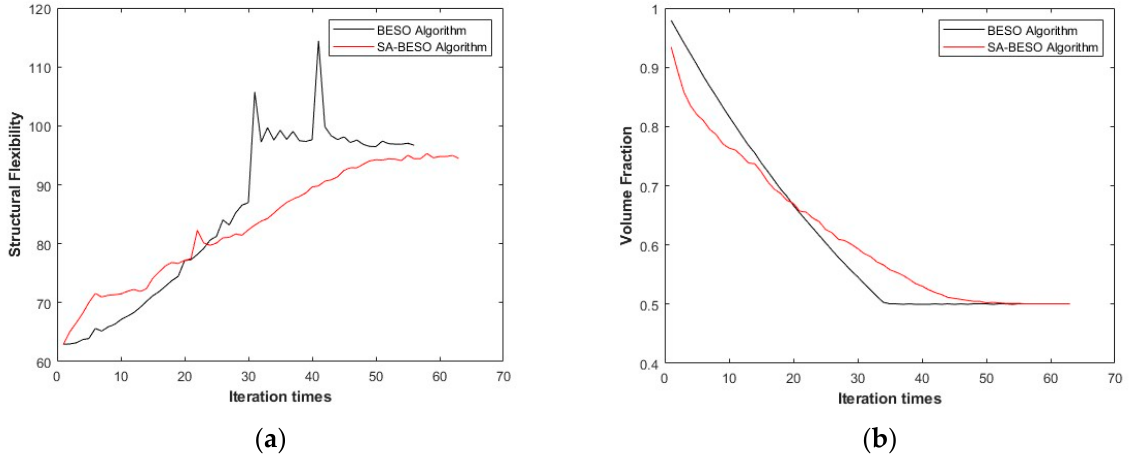
Figure 4. Evolution histories of structural compliance and volume fraction: ( a ) the changes in the structural compliance; ( b ) the changes in the volume.